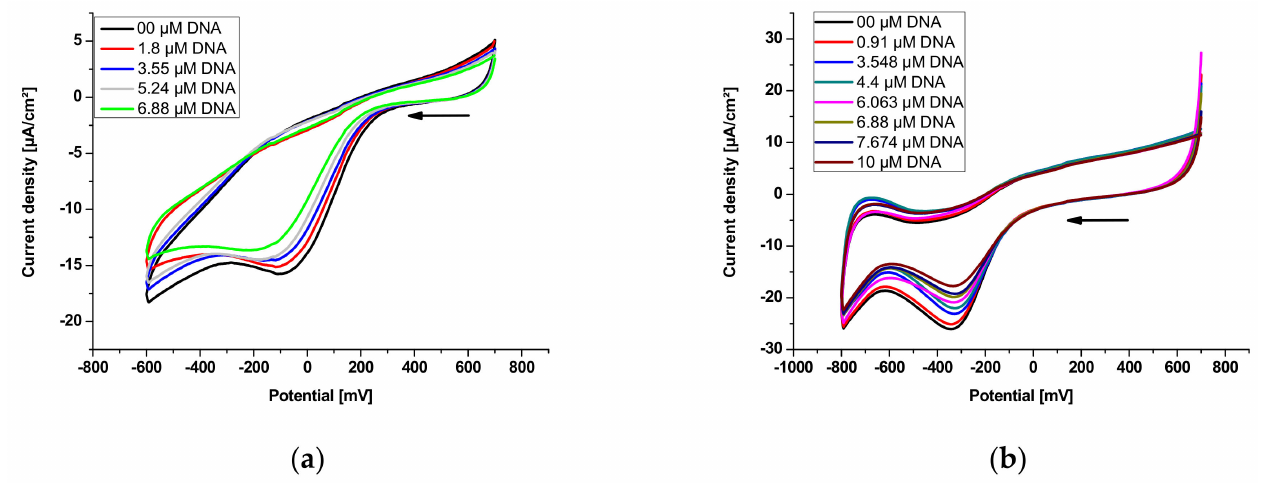
Figure 7. Cyclic voltammograms of polysaccharidic extracts in 12 mL of 0.1 M phosphate-buffered solution (KH 2 PO 4 /K 2 HPO 4 , pH = 7.2) recorded at a 0.1 Vs − 1 potential sweep rate on a platinum disk electrode at 298 K in the absence and presence of an increasing concentration of DNA with